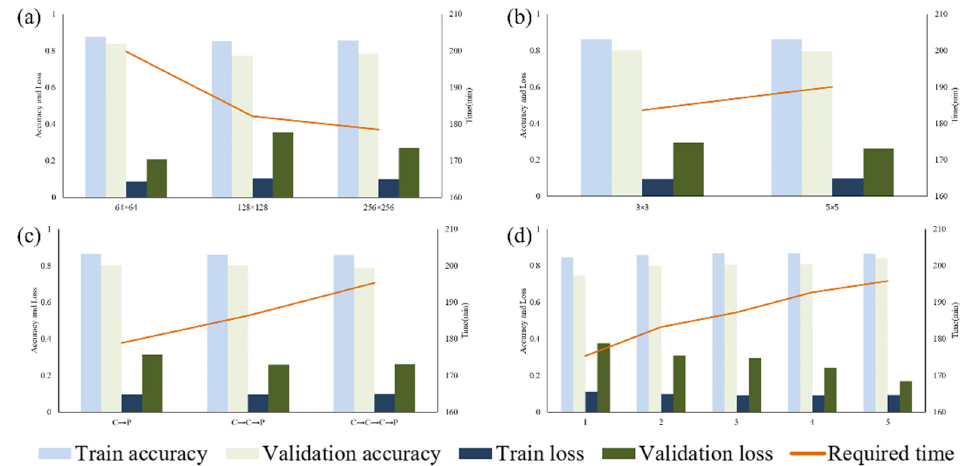
Figure 3. Comparison of the average accuracy and training time according to ( a ) image size, ( b )